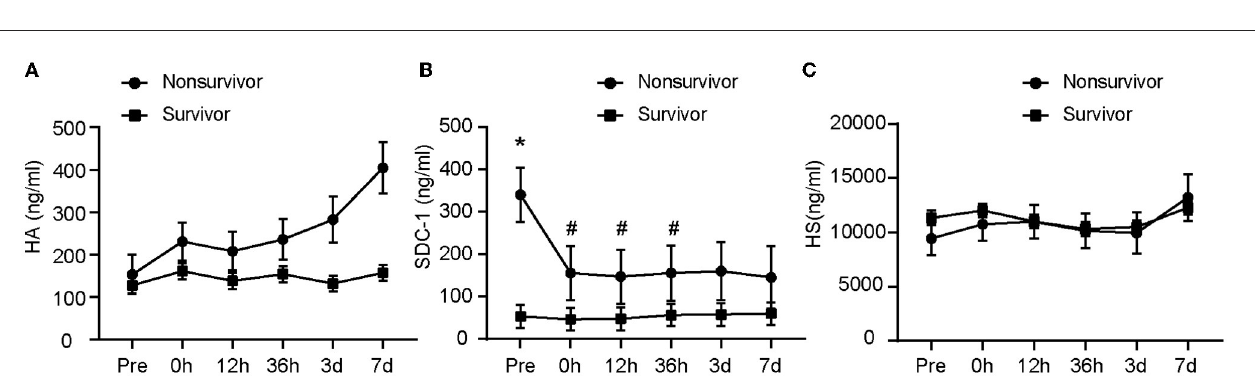
FIGURE3 The glycocalyx components at different outcomes. The difference in glycocalyx levels between the nonsurvivor group and the survivor group is shown from (A–C) . *represents p < 0.05 vs. survivor; # represents p < 0.05 vs. Pre. A linear mixed model was used to compare component concentrations between groups. Pre, pre-operation; 0h, 0h after the operation; 12h, 12h after the operation; 36h, 36h after the operation; 3 days, 3 days after the operation; 7 days, 7 days after the operation; HA, hyaluronic acid; SDC-1, syndecan-1; HS, heparan